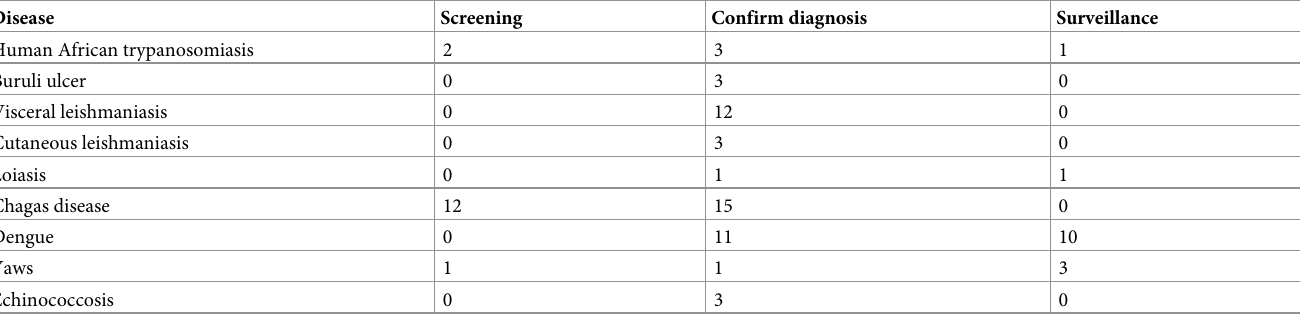
For diseases recommended to be controlled in part by mass drug administration, diagnos- tics may be used to guide decisions for mapping, initiating and stopping mass drug adminis- tration, surveillance or verifying the interruption of transmission (Table 3). Risk classification for diagnostics included in this analysis is presented in Table 4. For dis- eases such as lymphatic filariasis, soil-transmitted helminthiasis, schistosomiasis, onchocercia- sis and yaws, national elimination and control activities are implemented where preventive chemotherapy, i.e. regular administration of medicines to all population groups at risk of mor- bidity [35], is the main tool. Medicines used for mass drug administration, such as albenda- zole, mebendazole, ivermectin, praziquantel and azithromycin, have well documented safety profiles with only mild adverse events and low risk for individuals treated [36]; the associated diagnostics are therefore assigned to risk class B. Table 2. Number of diagnostics per purpose of diagnostics/intended use. Disease Screening Confirm diagnosis